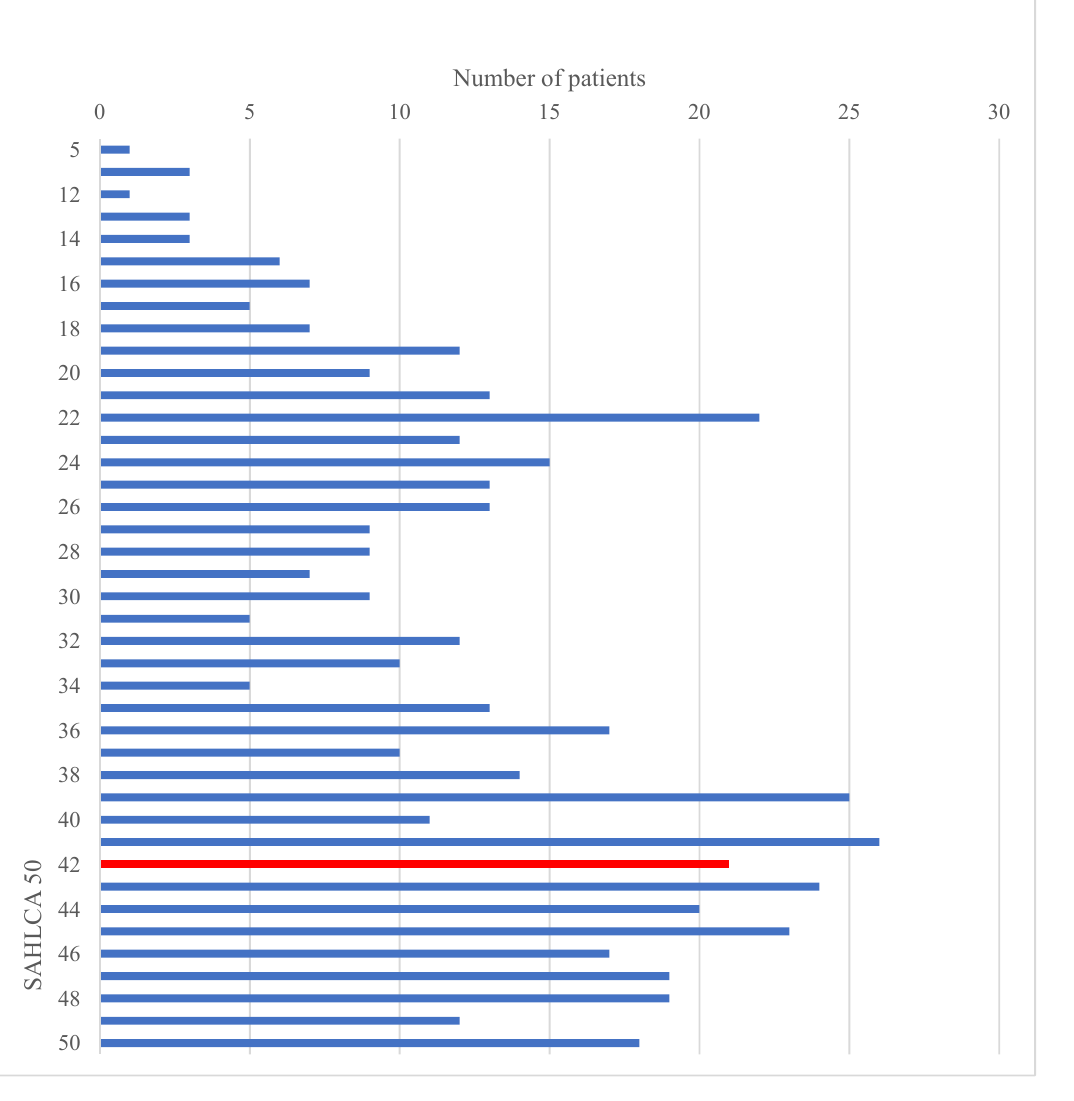
Figure 1. Patient distribution according to SAHLCA-50 questionnaire score: red line–cut-off value discriminating between subjects with an inadequate level of health literacy (0–41 points) and adequate health literacy (42–50 points).